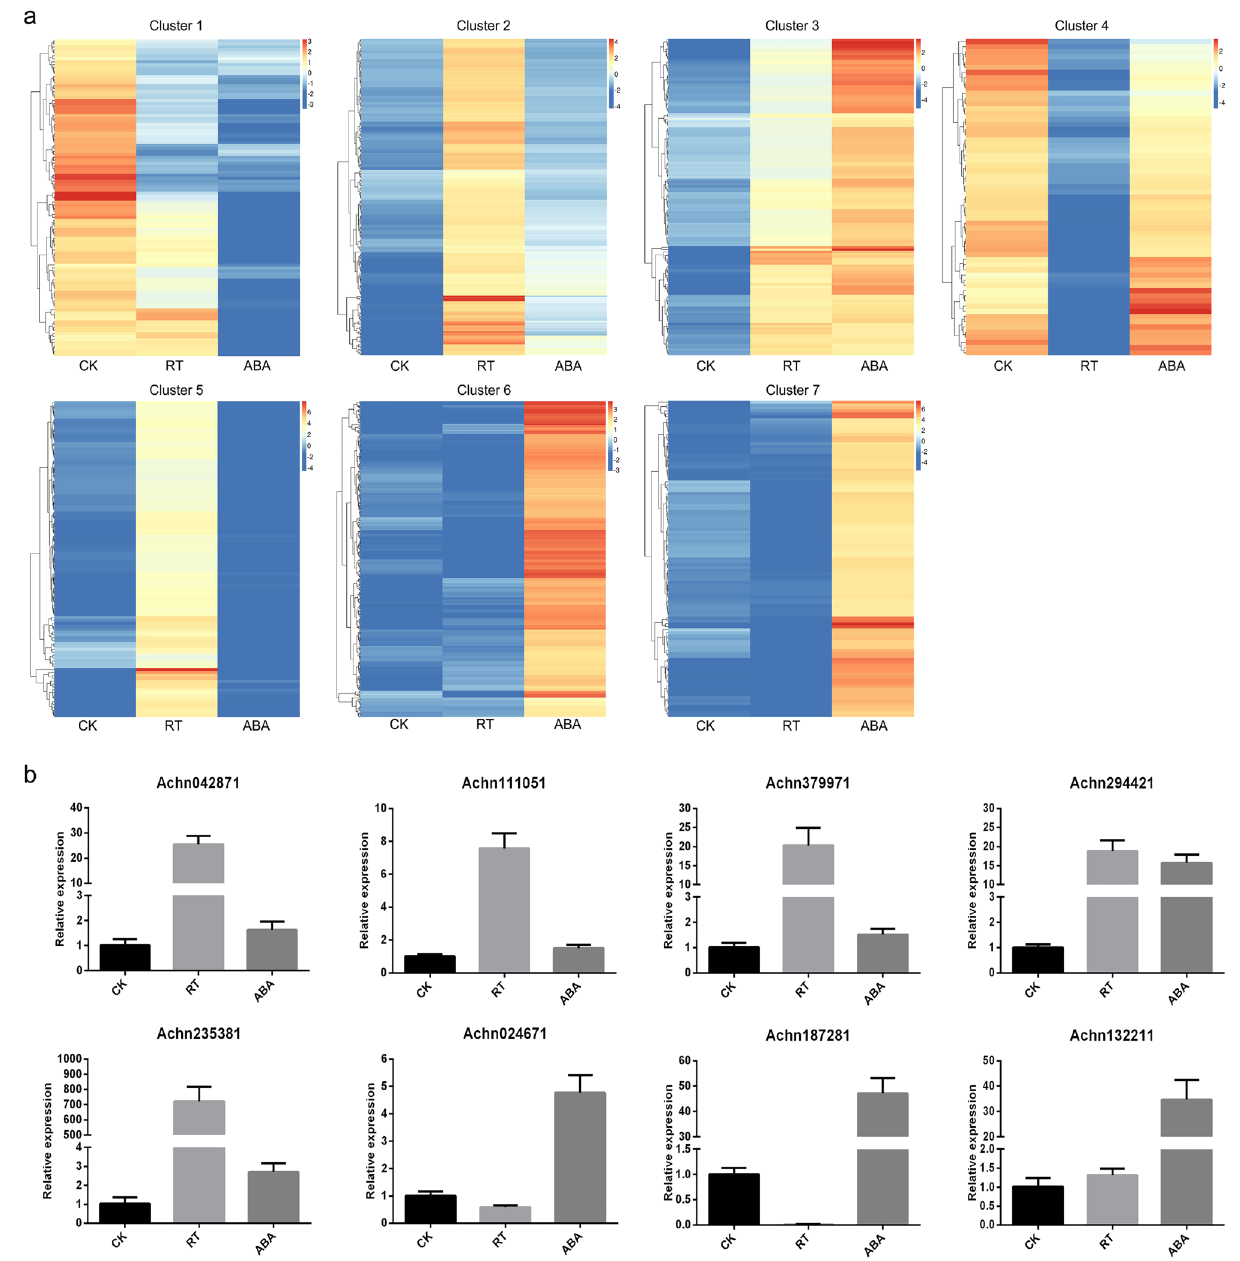
Figure 4. Clustering analysis ( a ) and qRT-PCR validation ( b ) of differentially expressed genes in kiwifruit. Achn042871, mannan endo-1,4-β-mannosidase 2; Achn111051, NAC transcription factor; Achn379971, cytochrome P450; Achn294421, β-galactosidase; Achn235381, MADS-box domain protein; Achn024671 and Achn187281, ethylene response factor; Achn132211, peroxidase. CK, freshly harvested fruits (fruit maturity stage); RT, fruits stored at 25 °C for 7 days (postharvest ripening stage); ABA, fruits treated with 50 mg/L ABA for 2 min and then stored at 25 °C for 7 days (softening